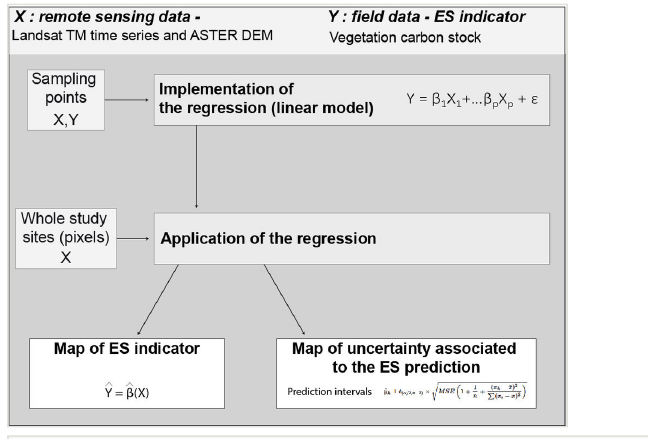
Figure 2. General methodology used to map the ES indicator and the estimate the uncertainty associated to the